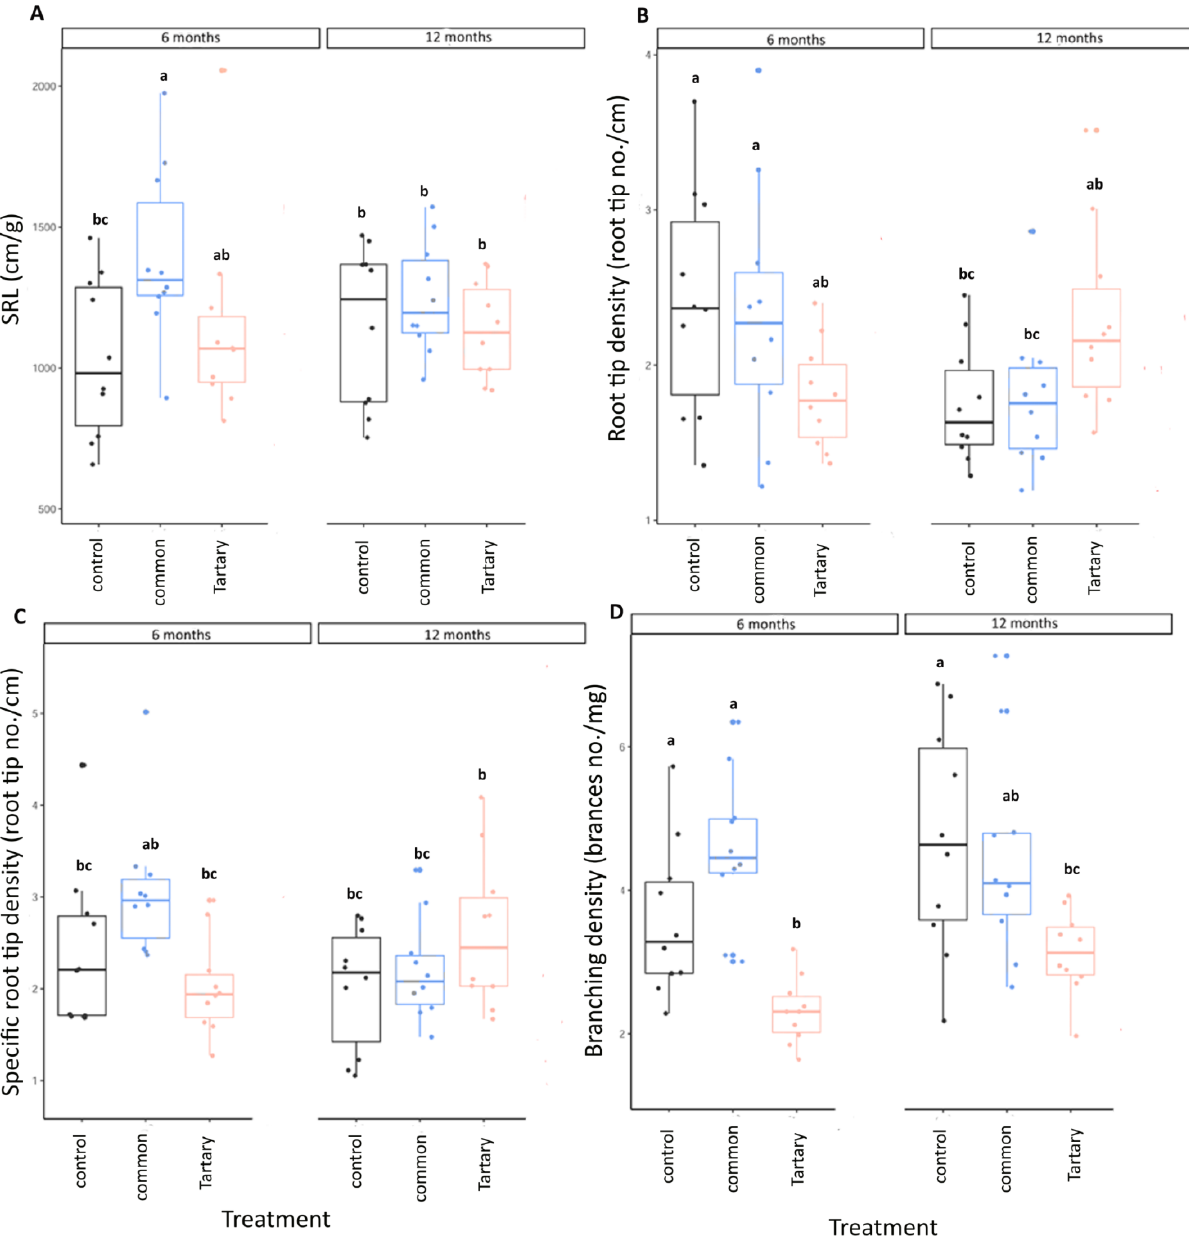
Figure 3. Impact of buckwheat bran on root parameters at 6 and 12 months after spore inoculation: ( A ) Specific root length (SRL) (cm/mg); ( B ) root tip density (no. of root tips/cm); ( C ) specific root tip density (no. of root tips/mg); and ( D ) branching density (no. of branches/mg). Different letters mark statistically significant results (Tukey HSD, p ≤ 0.05).